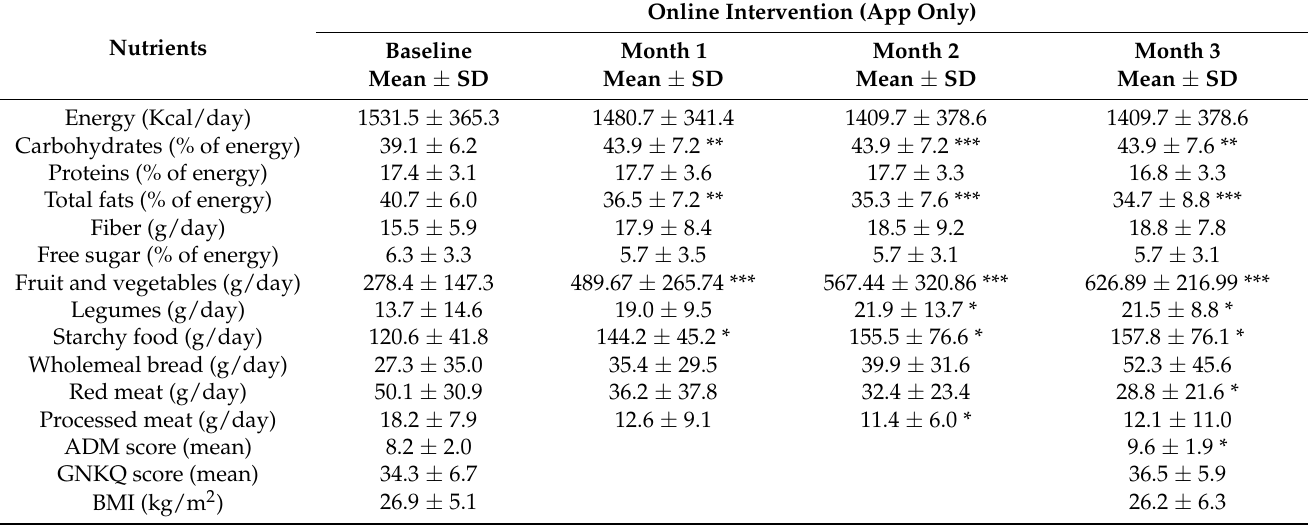
Table 4. Energy and macronutrient intake, adherence to MD, and nutritional knowledge scores over three months in the online